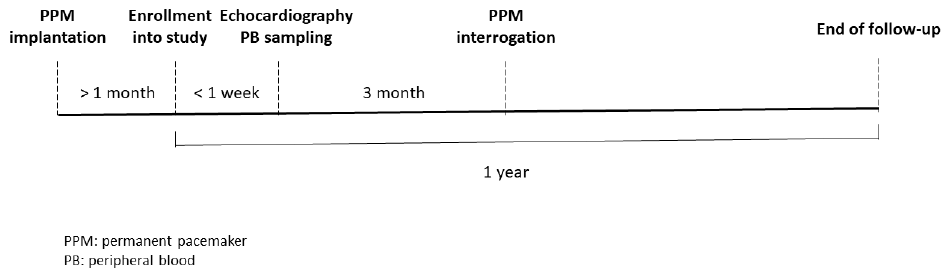
Figure 1. Flow chart of study